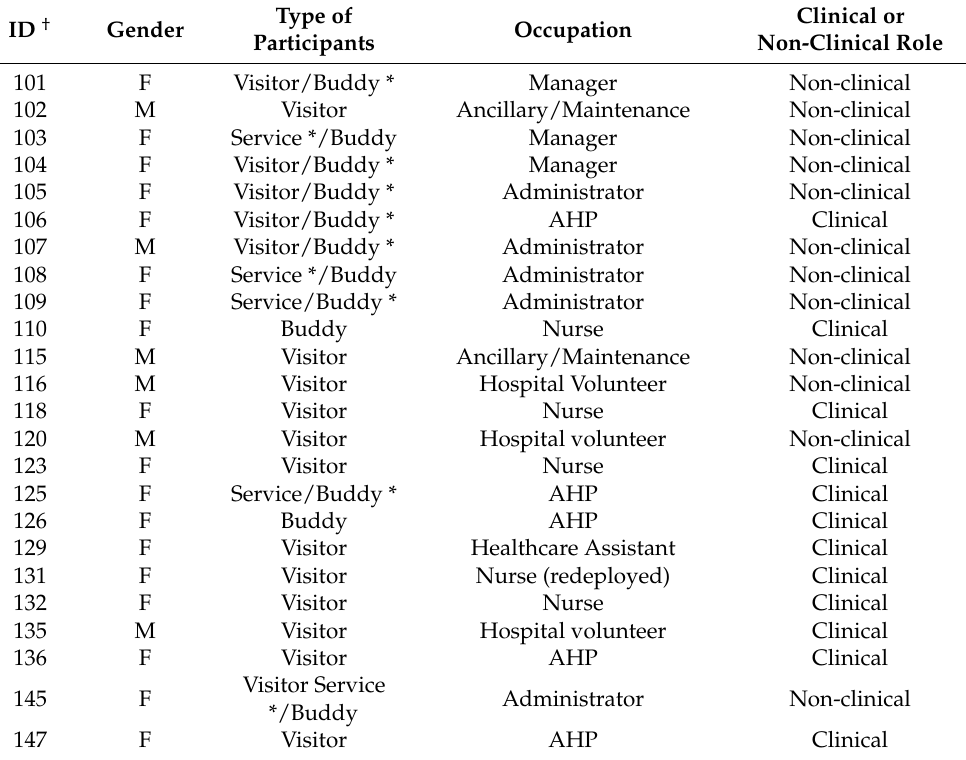
Table 1. Sample characteristics for interview